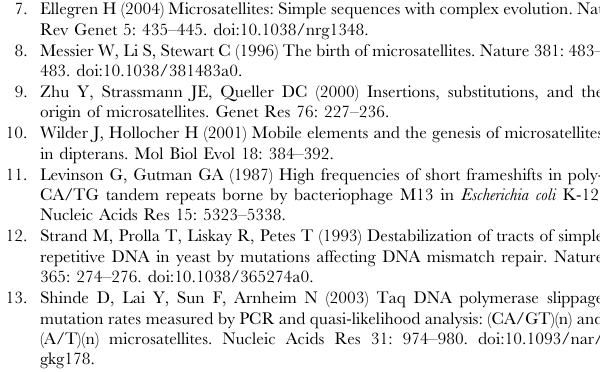
Figure S3 Proportion of the six most frequent tetranu- cleotide motifs within the total tetranucleotide micro- satellite coverage. Species follow the same order as in Dataset S1 and in Figures 1 and 2. (TIF) Figure S4 Proportion of the six most frequent pentanu- cleotide motifs within the total pentanucleotide micro- satellite coverage. Species follow the same order as in Dataset S1 and in Figures 1 and 2. (TIF) Figure S5 Proportion of the six most frequent hexanu- cleotide motifs within the total hexanucleotide micro- satellite coverage. Species follow the same order as in Dataset S1 and in Figures 1 and 2. (TIF) Dataset S1 Species list and the number of bases in microsat- ellites or homopolymers for each investigated species. Columns included are: Species names, taxonomic groups, contact person, total length of the 454 sequences, GC proportions of 454 dataset, and the number of base pairs of microsatellites for each repeat unit length and for each